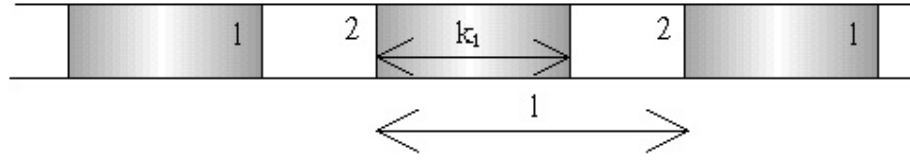
Figure 1. Monodisperse chain of composite inhomogeneities. Conditions at the boundaries of the fundamental cell